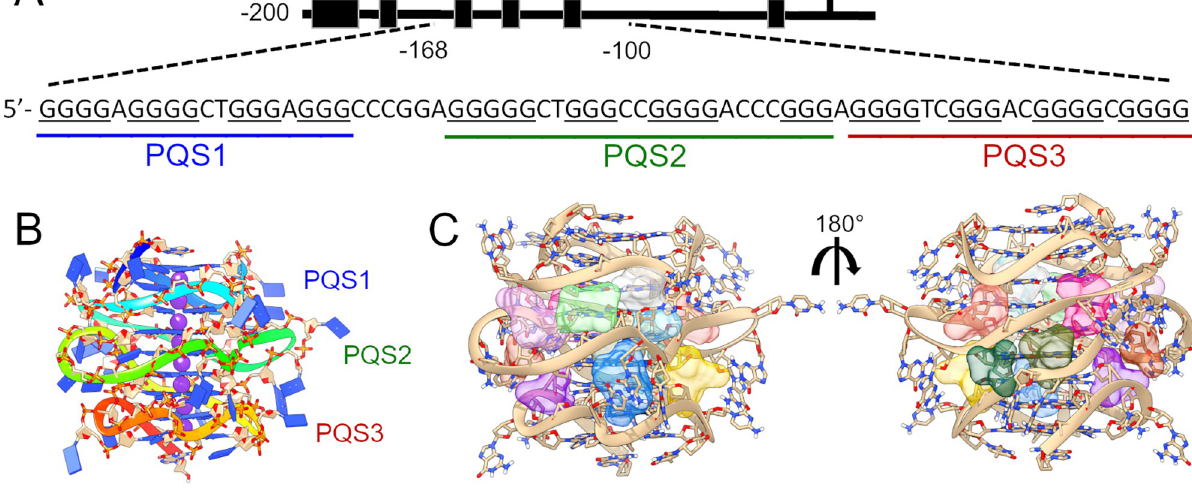
Fig 1. The hTERT core promoter and higher-order G-quadruplex. (A) The hTERT core promoter spanning from -200 to +1 with known Sp1 binding sites and Myc E-box motif represented schematically. The hTERT G4 region is displayed with putative quadruplex forming sites (‘PQS’) highlighted. (B) The hTERT higher-order G4 from refs [31, 33] with color coding from 5’ (blue) to 3’ (red), corresponding to the blue, green, and red underlined regions in A. (C) Surflex-Dock virtual screening sites represented as 12 space-filling protomols of various colors situated among the loops and grooves of the model in